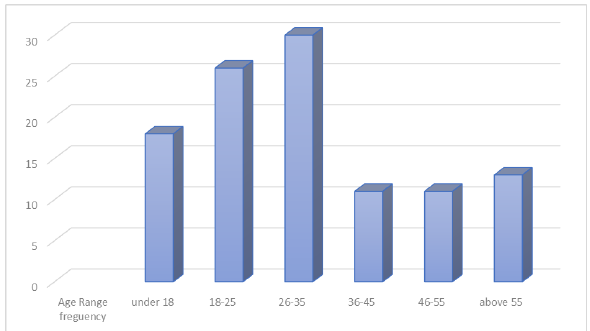
Figure 8: Age Description of Mobilized and Participated Map- pers